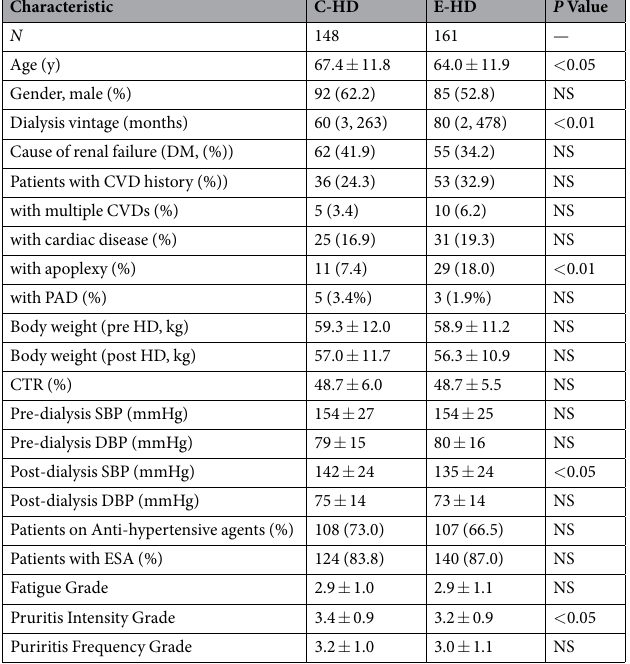
(Table 3). In Cox proportional hazards model analysis, possible risk factors for the primary endpoints, which were identified via p-values < 0.1, were depicted, e.g., E-HD dialysis modality, age, history of cardio-cerebrovascular disease (CVD), serum albumin, and CRP. Multivariate analysis after adjusting for these factors revealed E-HD as an independent significant factor for the primary event (hazard ratio [HR] 0.59 [95% confidence interval [CI]: 0.38–0.92]) (Fig. 3 and Table 4).